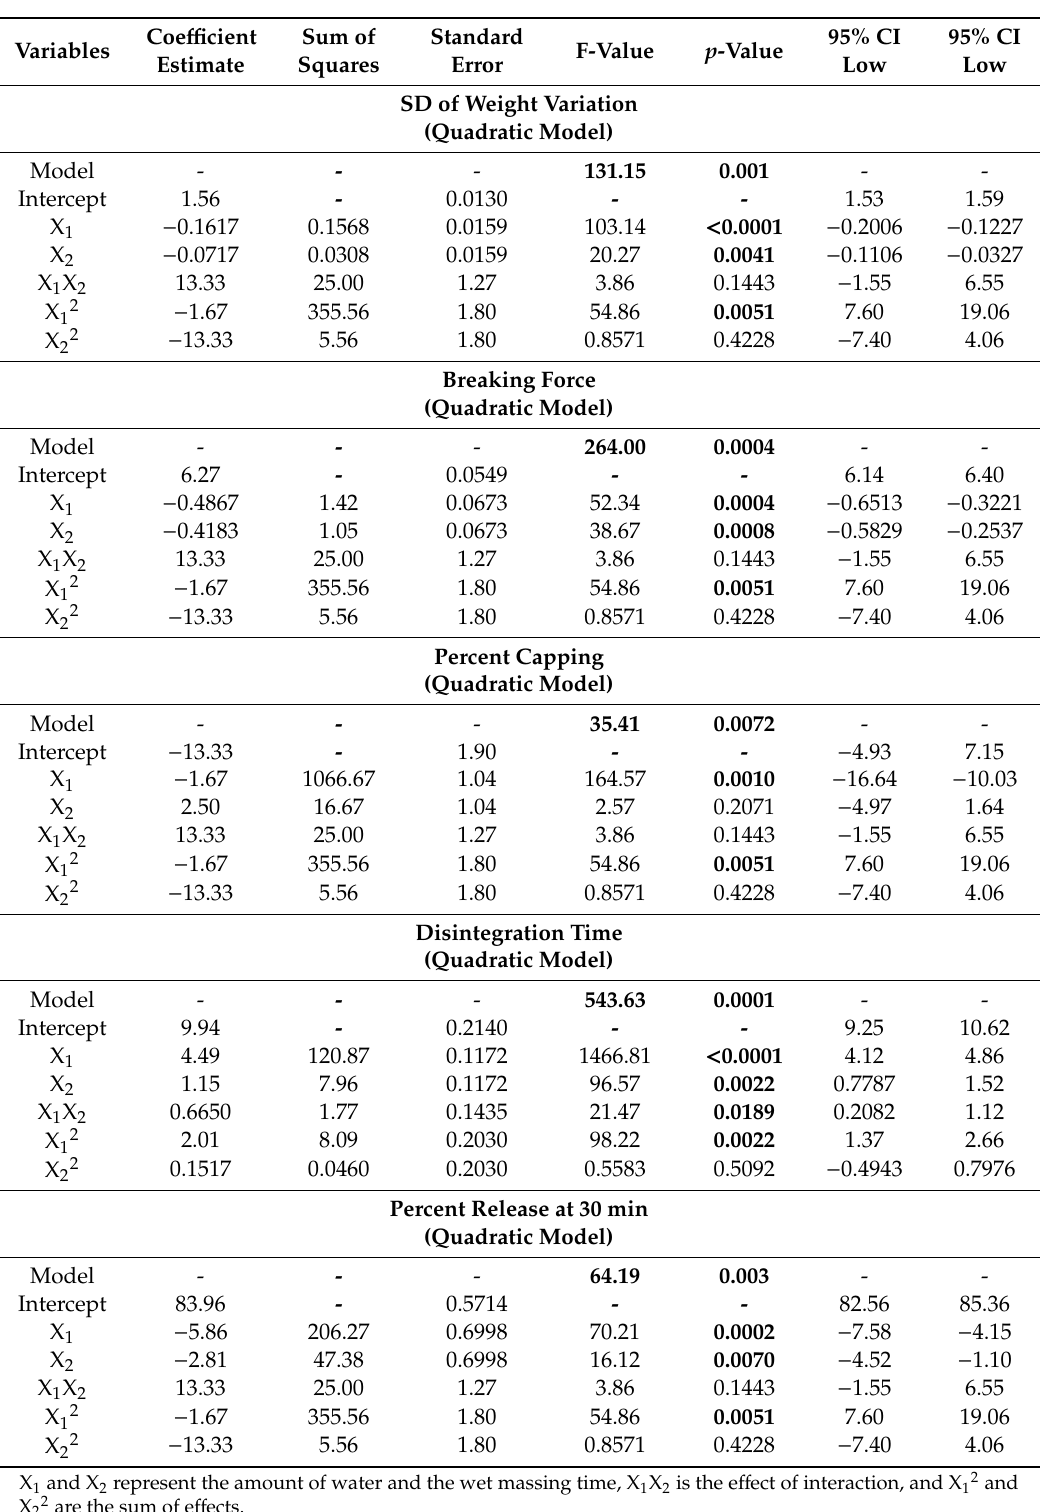
Table 9. Analysis of variance (ANOVA) summary and regression analysis of tablets’ dependent